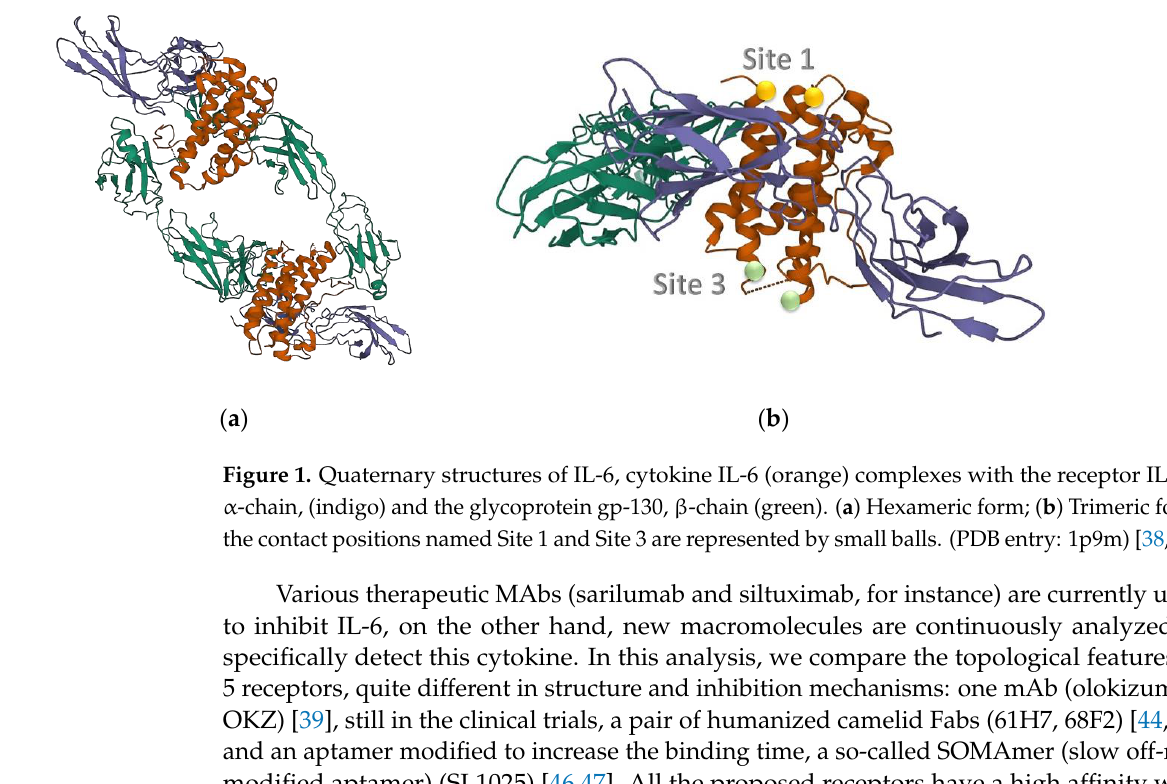
5 receptors, quite different in structure and inhibition mechanisms: one mAb (olokizumab,